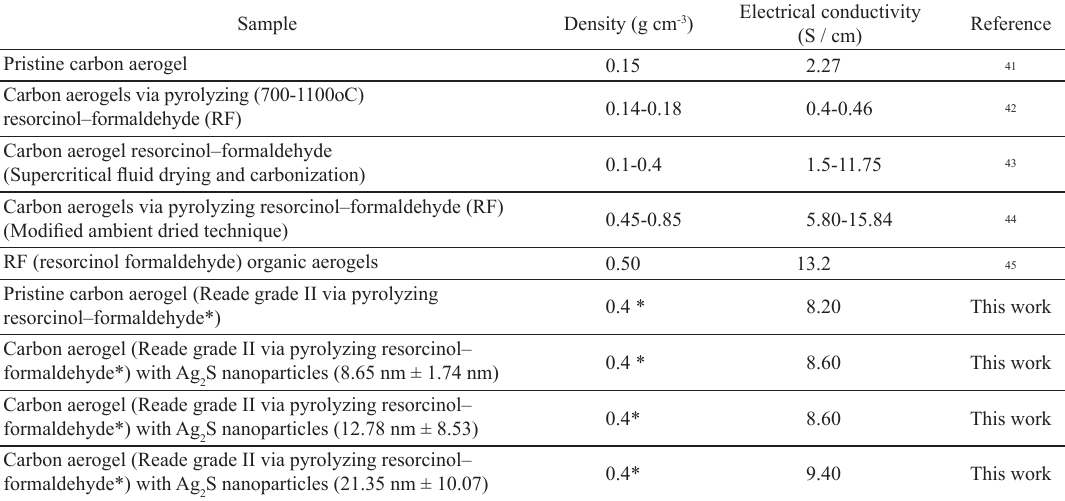
Table 2. Comparison of carbon aerogel densities and electrical conductivities.